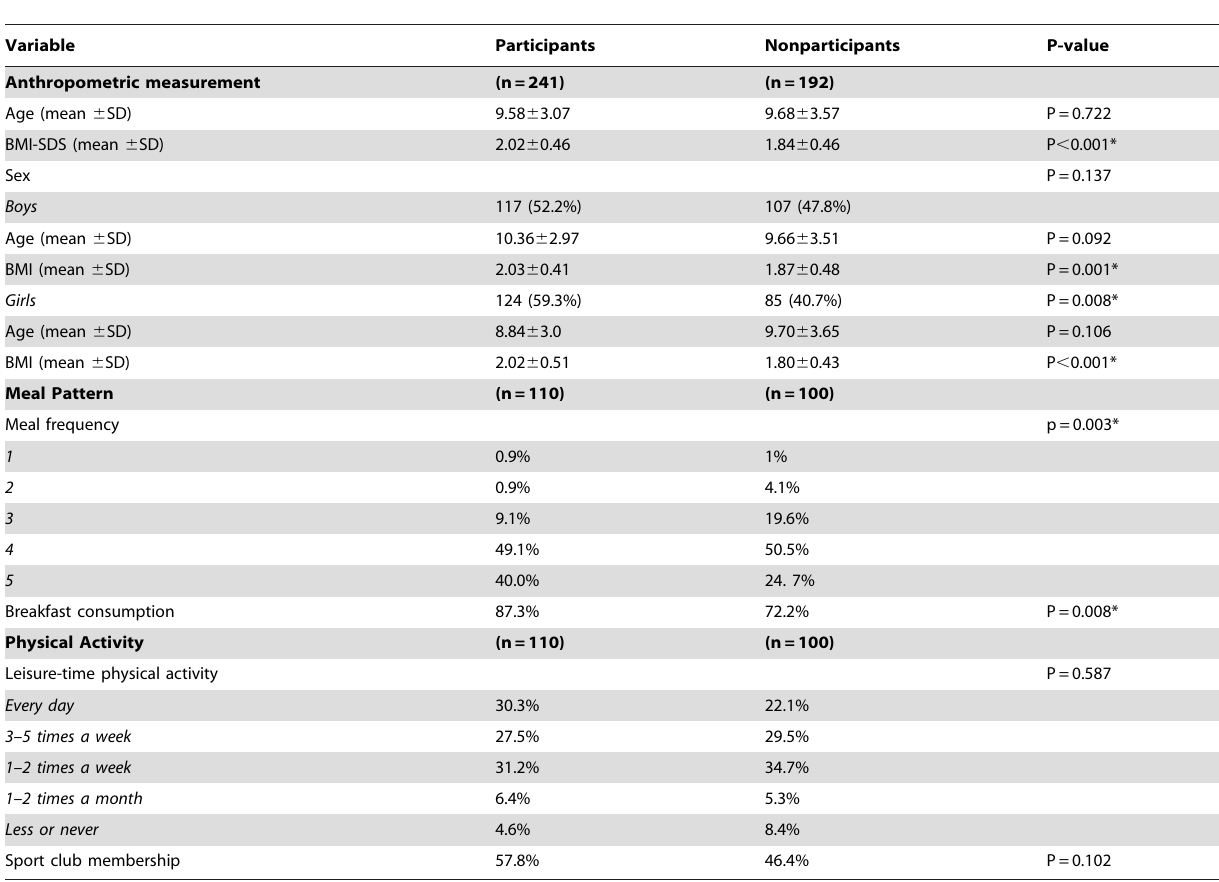
Table 1. Baseline characteristics of participating and nonparticipating